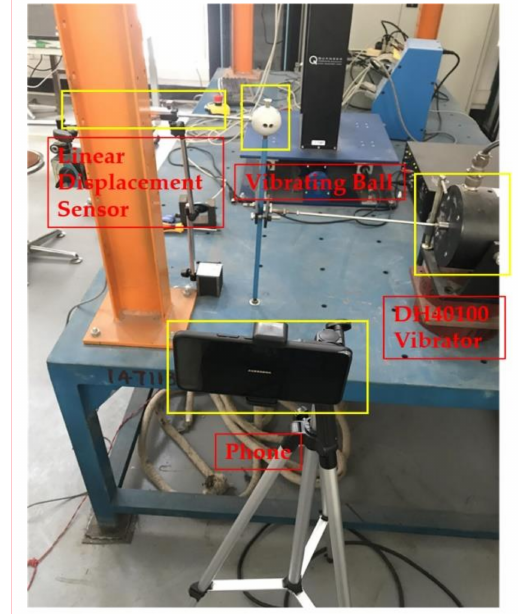
Figure 9. Experiment